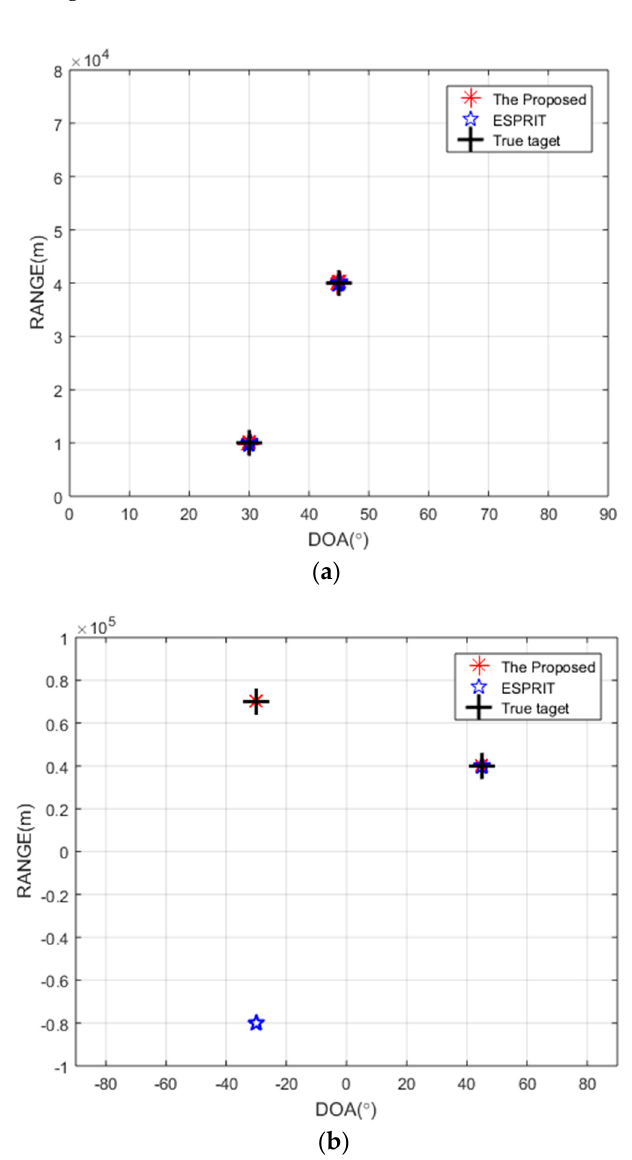
Figure 4. Location of the target under different target parameters by the proposed algorithm and ESPRIT algorithm. ( a ) Targets without phase ambiguity; ( b ) targets with phase ambiguity.